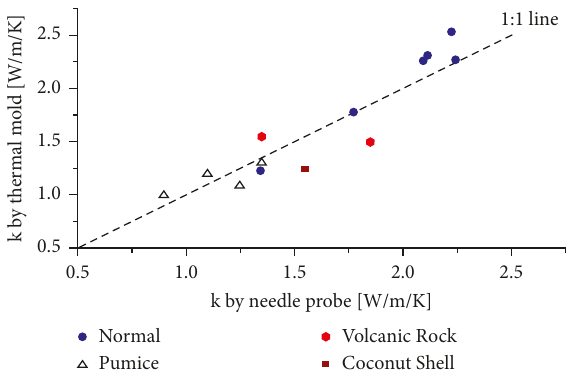
Figure 10: Thermal conductivity by the thermal needle probe and thermal molding